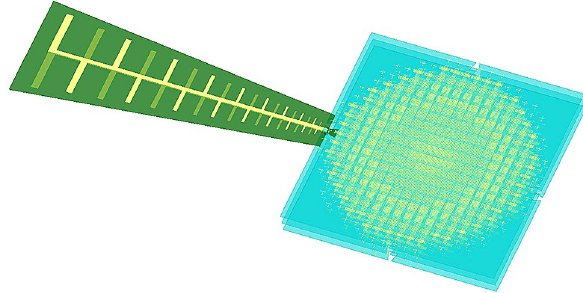
Figure 10. Schematic diagram of the whole system after assembly.